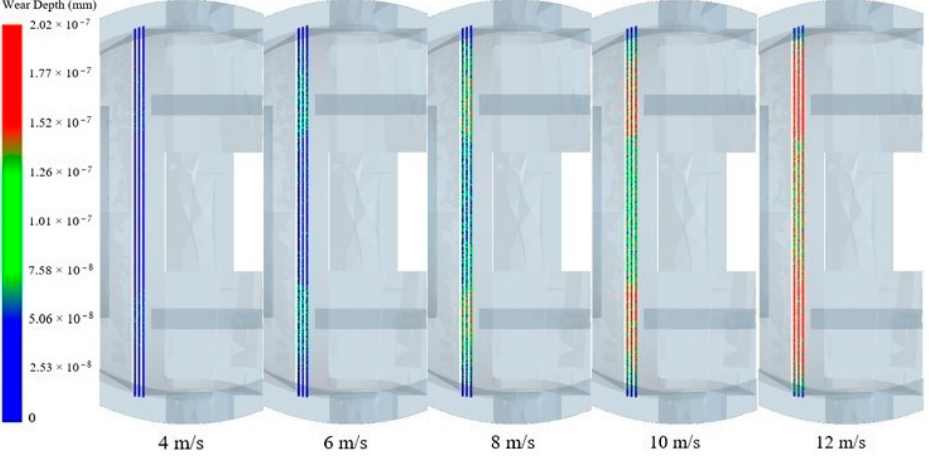
Figure 15. Wear cloud of sealing surface at different speeds.